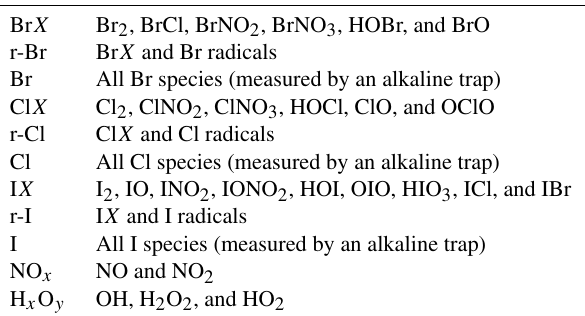
Table 2. Overview of chemical species’